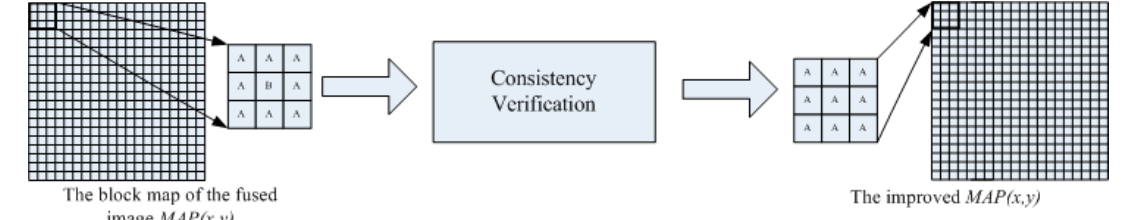
Figure 5. Majority filter in consistency verification to improve MAP ( x , y ).